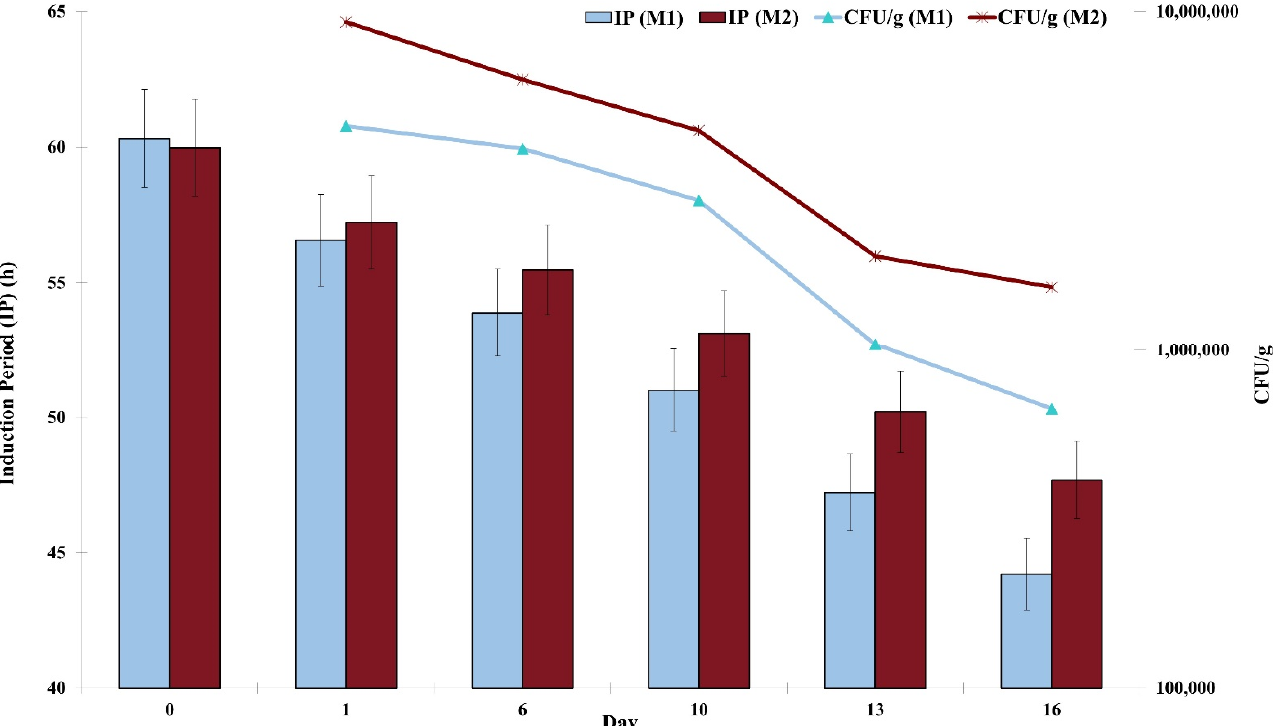
Figure 2. Induction periods (IP) and colony-forming units (CFUs) per g of lipid phase of tzatziki samples M1 and M2 during 16 days of storage.